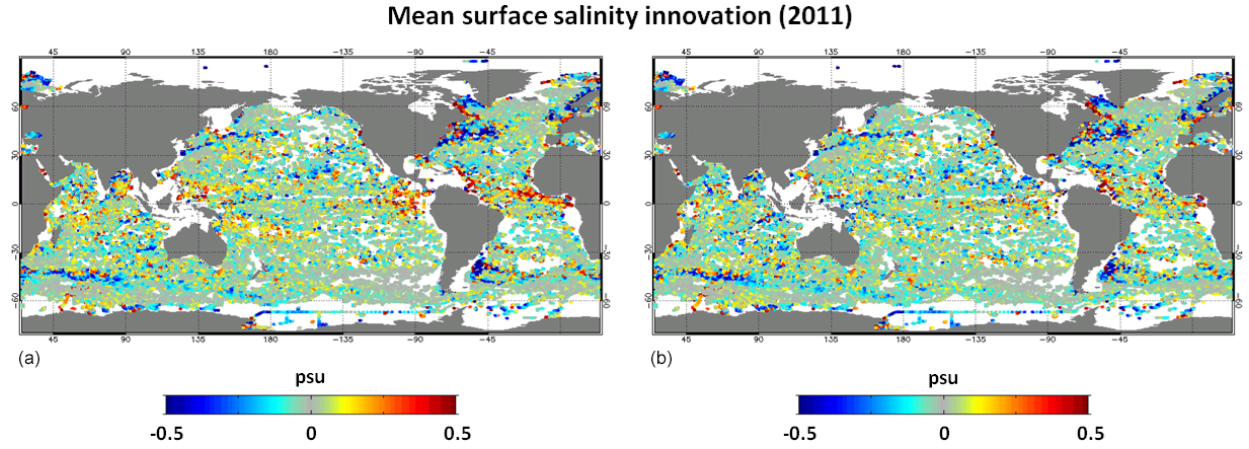
Figure 7. Mean surface salinity innovation (difference between the assimilated observation and the model; units in psu) in the year 2011. (a) The innovation resulting from the use of the original IFS field, and (b) the innovation resulting from the use of the corrected IFS field.